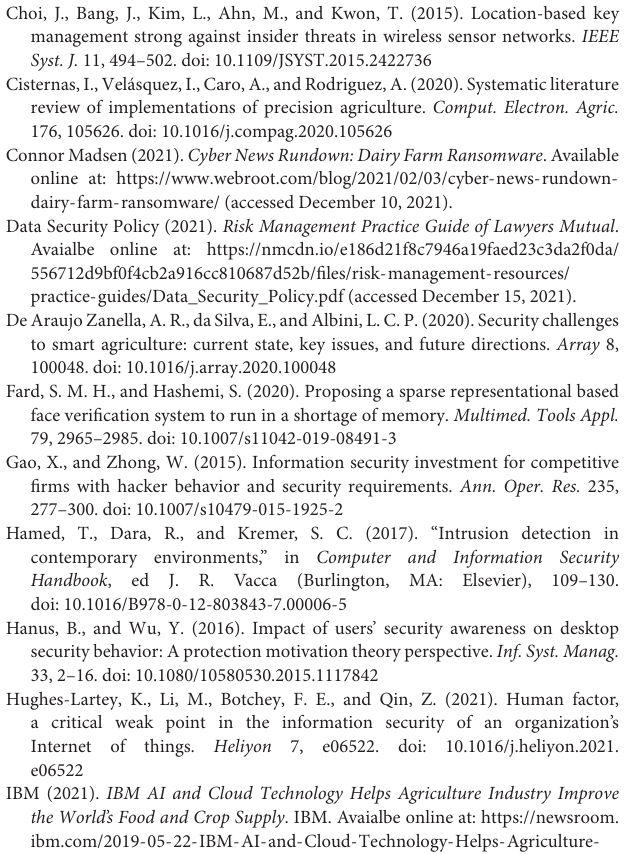
Table 2 provides recommendations on security practices that ATPs can adopt to secure farm data and digital